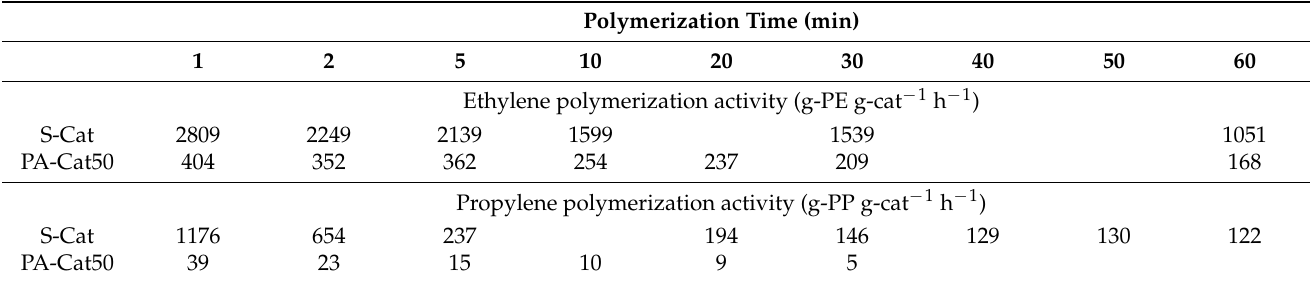
Table 2. Summary of ethylene and propylene polymerization